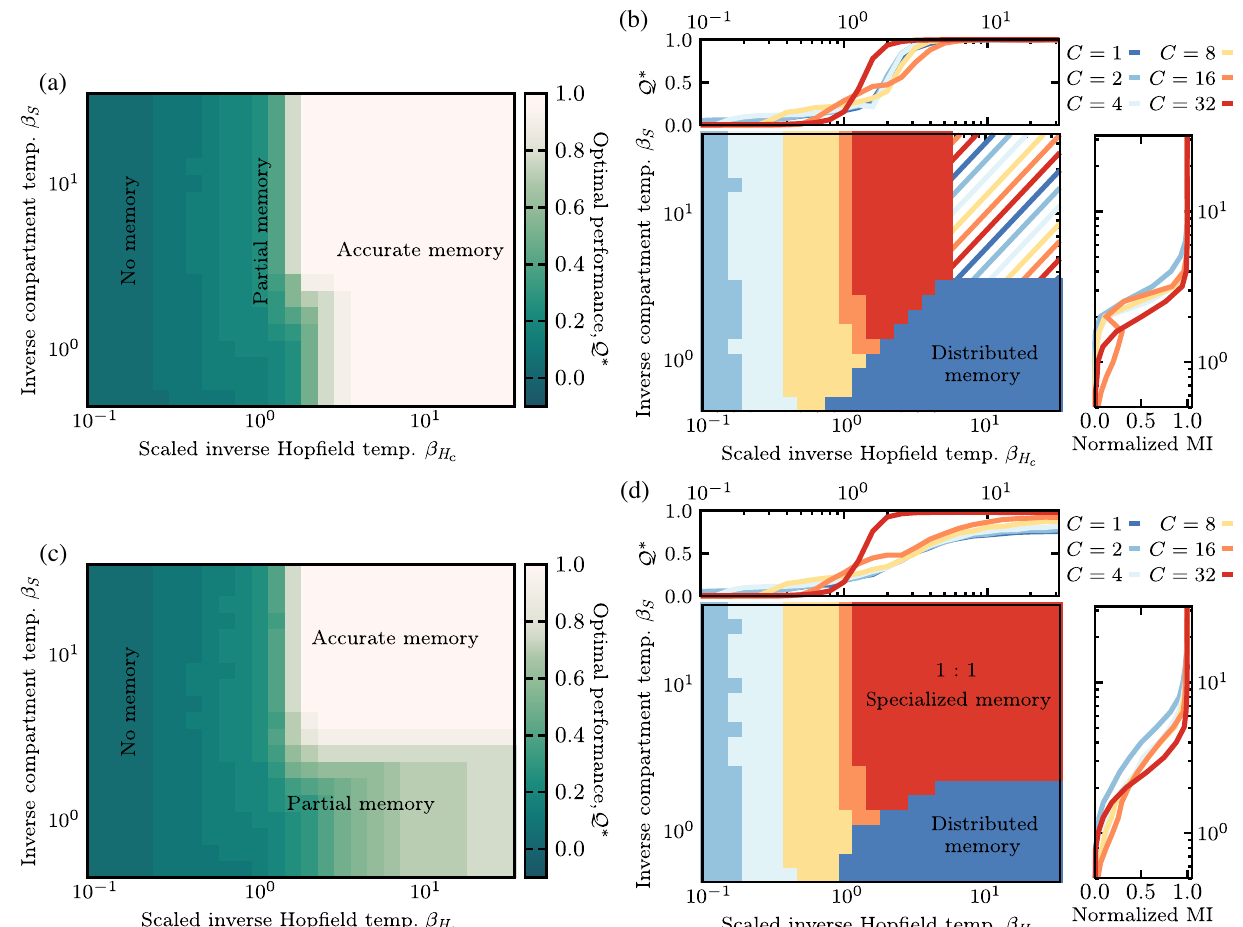
FIG. 4. Phases of learning and memory production. Different optimal memory strategies are shown. (a) The heat map shows the β C and the inverse temperature optimal memory performance Q (cid:4) as a function of the (scaled) Hopfield inverse temperature β H c ¼ H associated with compartmentalization β for networks learning and retrieving a memory of static patterns ( μ ¼ 0 ); colors are S indicated in the color bar. The optimal performance is achieved by using the optimal strategy (i.e., learning rate λ (cid:4) and the number of c compartments c (cid:4) ) for networks at each value of β and β . The three phases of accurate, partial, and no memory are indicated. H c S (b) The heat map shows the memory strategies for the optimal number of compartments (colors as in the legend) corresponding to the memory performance shown in (a). We limit the optimization to the possible number of compartments indicated in the legend to keep N=C an integer. The dashed region corresponds to the case where all strategies perform equally well. Regions of distributed memory ( C ¼ 1 ) and the 1-to-1 specialized memory ( C ¼ N ) are indicated. The top panel shows the optimal performance Q (cid:4) of different strategies as a function of the Hopfield inverse temperature β . The right panel shows the mutual information MI ð Σ ; C Þ H c between the set of pattern classes Σ ≡ f σ α g and the set of all compartments C normalized by the entropy of the compartments H ð C Þ as a function of the inverse temperature β ; see Appendix A. This normalized mutual information quantifies the ability of the system S to assign a pattern to the correct compartment. (c),(d) Similar to (a),(b) but for evolving patterns with the effective mutation rate μ 0 . 01 . The number of presented patterns is set to N ¼ 32 (all panels). Similar to Fig. 3, we keep L × C ¼ const, with L ¼ 800 eff ¼ used for networks with C ¼ 1